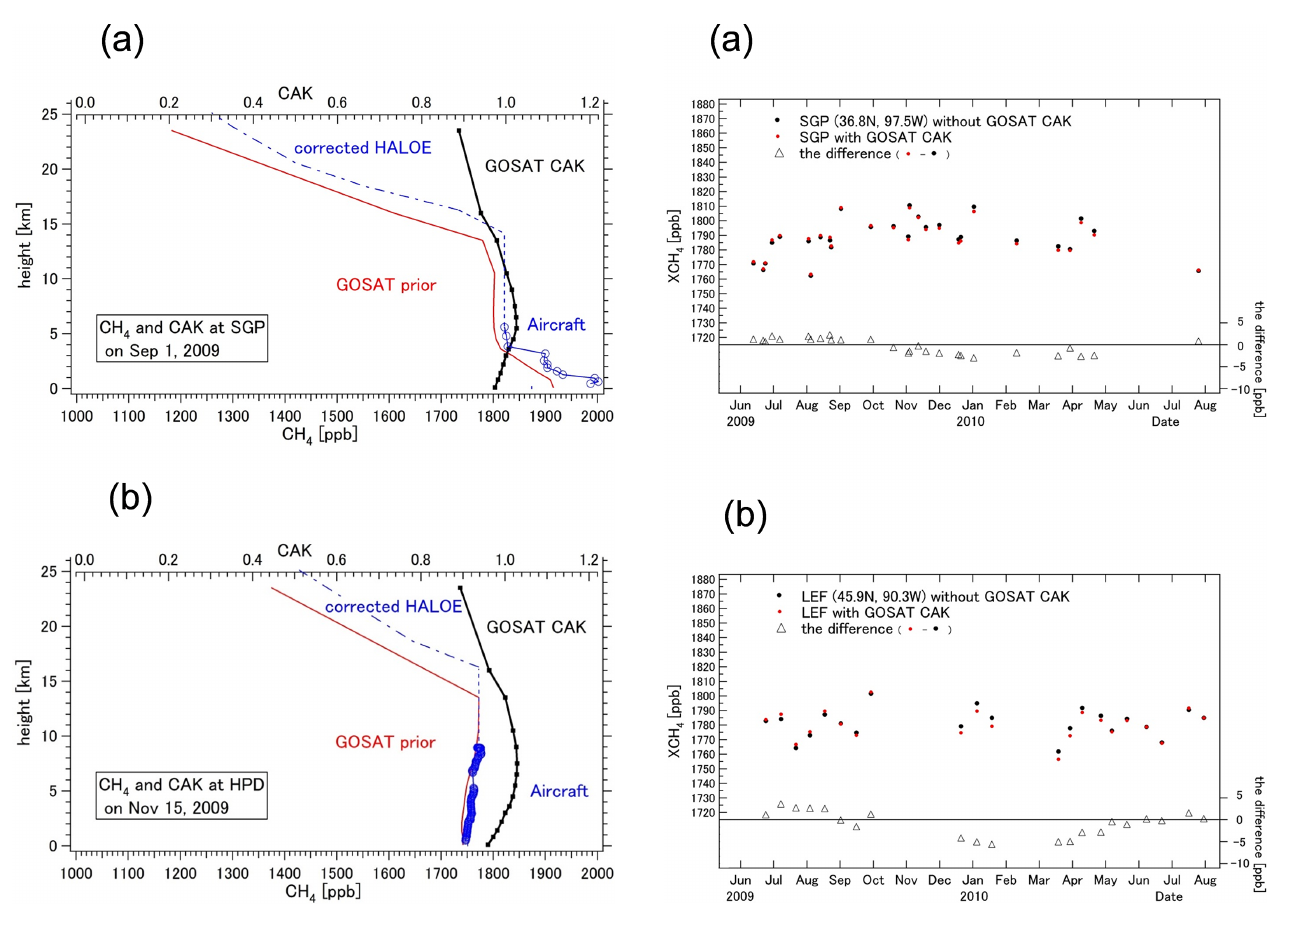
Figure 6. Vertical profiles of CH 4 and GOSAT SWIR CAK over (a) the Southern Great Plains (SGP) on 1 September 2009 and over (b) the western part of Chesterfield Islands (HPD) on 15 Novem- ber 2009. The blue circles represent aircraft measurements and are connected with solid lines. The dash-dotted lines represent profiles above the tropopause based on HALOE data corrected by ACE- FTS data, and the dashed lines show where the CH 4 profiles were assumed. The red lines represent the GOSAT a priori profiles, and the black lines show GOSAT CAK.